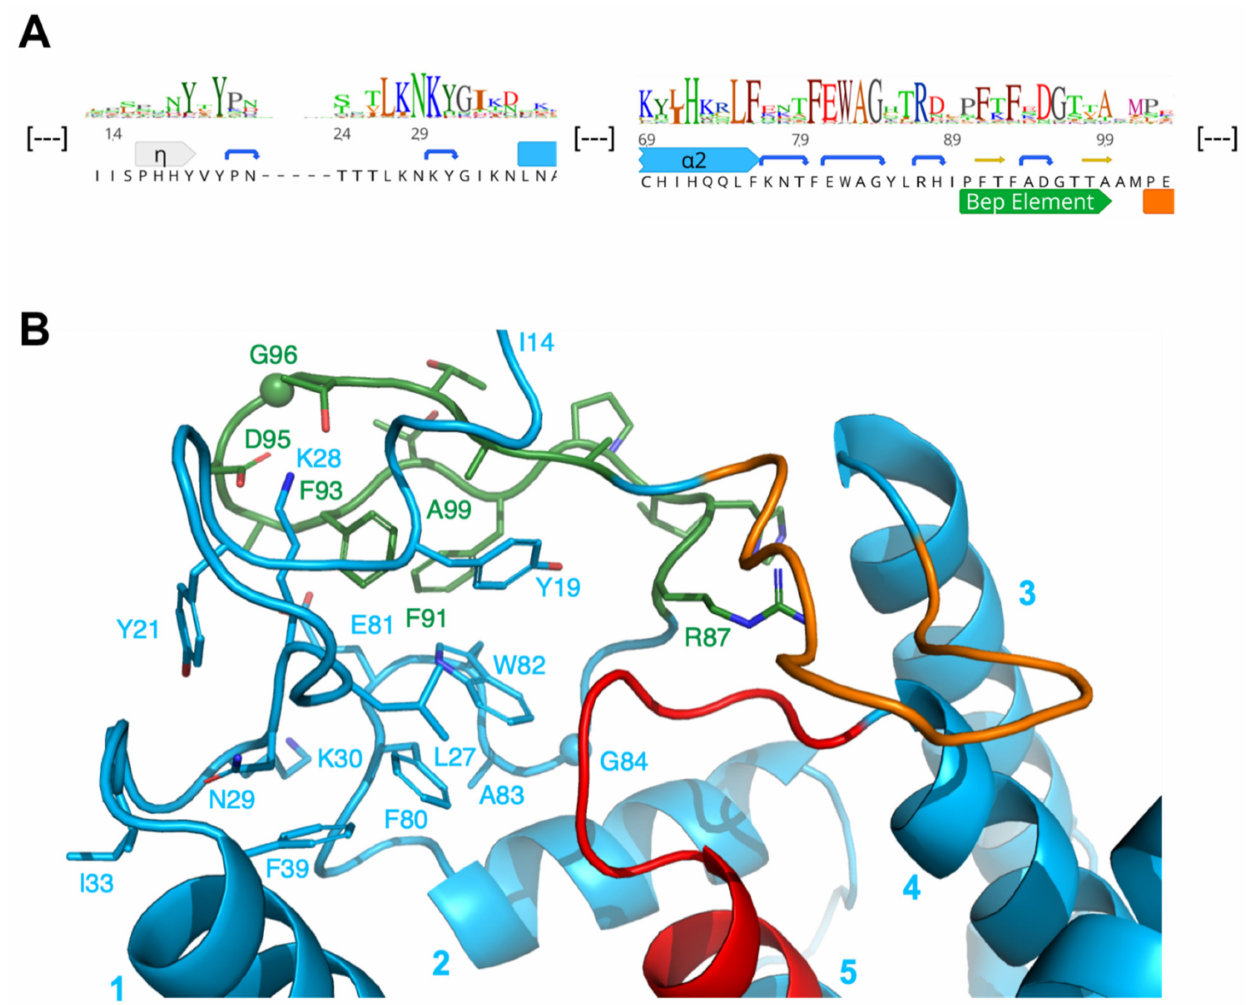
Figure 4. Sequence and structure of the N-terminal that is part of Bhe_ BepA. ( A ) Excerpt of the N-terminal part of the sequence logo shown in Figure 3 with Bhe_BepA sequence below. ( B ) Detailed view of the N-terminal that is part of the Bhe_BepA structure (5NH2) showing the close interactions between the segments preceding α 1 (residues 2–33), the FEWAG segment following α 2 (80–84), and the Bep element (90–99, green). Various conserved residues are